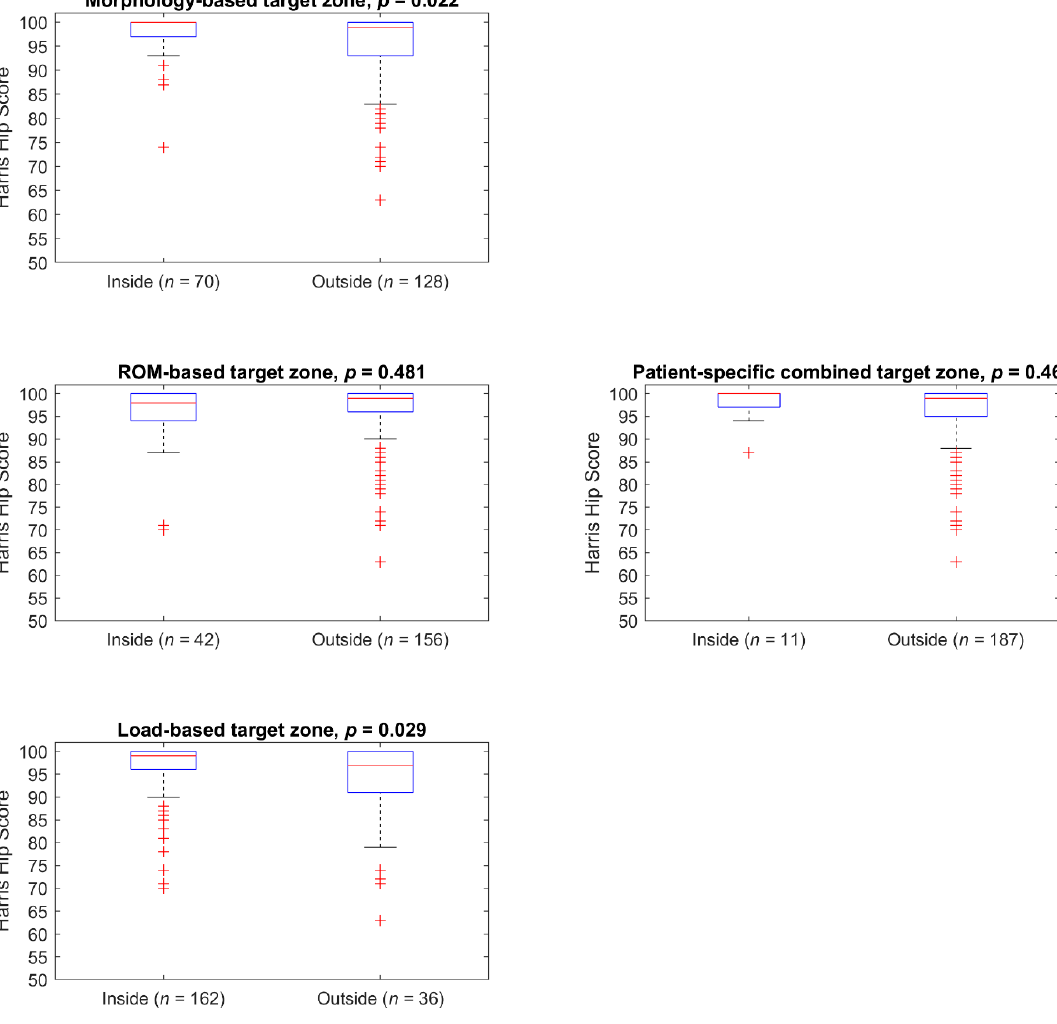
Figure 10. HHS of the patients divided by individual and combined target